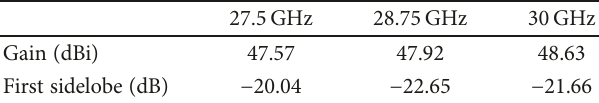
Table 1: Measured data of antenna transmitting patterns.